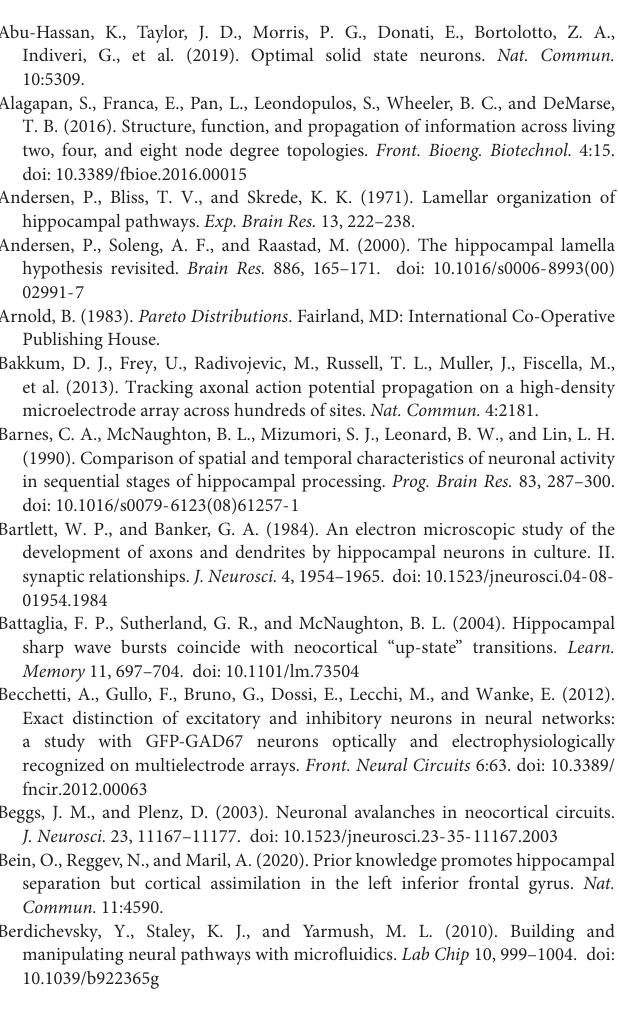
Supplementary Figure 1 | Examples of spike sorting from axons crossing two electrodes in a single microfluidic tunnel. The goal is to pair sorted units on one tunnel electrode with the units on the other tunnel electrode. (A) Spike sorting on one electrode on the CA1 side of the tunnel (F9) indicates three units with spike counts. (B) The second electrode (G9) on the CA3 side also indicates three units. The matching algorithm examines the relative timing of the spikes to calculate normalized matching index (NMI) to match units, proceeds to assign feed-forward or feedback direction, and calculates conduction velocity (delay time/200 µ m spacing of electrodes) for the matched axons. (C) Example of a spike delay corresponding to the FB axon with a spike delay of 0.52 ms, indicating spike propagation in feedback direction with a velocity of 0.37 m/s. (D) Example NMI matrix calculated between three sorted units in the CA1 side of the tunnel and three sorted units in the CA3 side of the tunnel. NMI quantifies the fraction of total spikes that are within delay times of 0.1 and 1 ms (corresponding to known conduction velocities of 0.2–2 m/s). Units with maximum NMI (above threshold of 0.2) are matched together as belonging to the same axons. Two NMI values indicated in red belong to the two axons identified, which are unit 1 in CA1 paired with unit 1 in CA3, and unit 3 in CA1 paired with unit 2 in CA3 [see also arrows in panels (A,B) ]. The latter of the two axons has an NMI of 0.34, indicating that 34% of paired spikes are within physiological conduction time delays between the two units. (E) Positive conduction velocities (m/s) are interpreted as feed-forward signals, negative as feedback. (F) Distribution of delay times between unit 1 in CA1 side electrode and unit 1 in CA3 side electrode. This delay is centered at